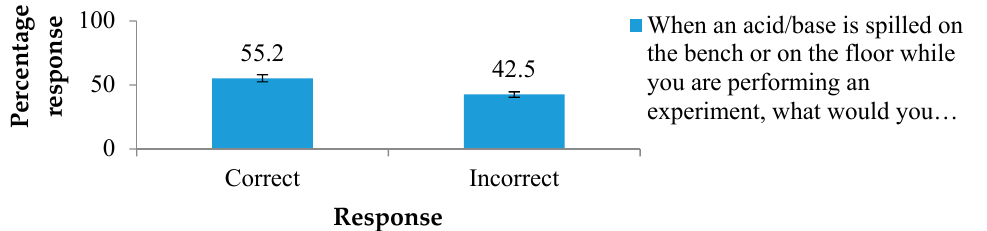
Figure 8. Percentage distribution of students’ response for the questions on Emergency Equipment and Procedures (Question 30).